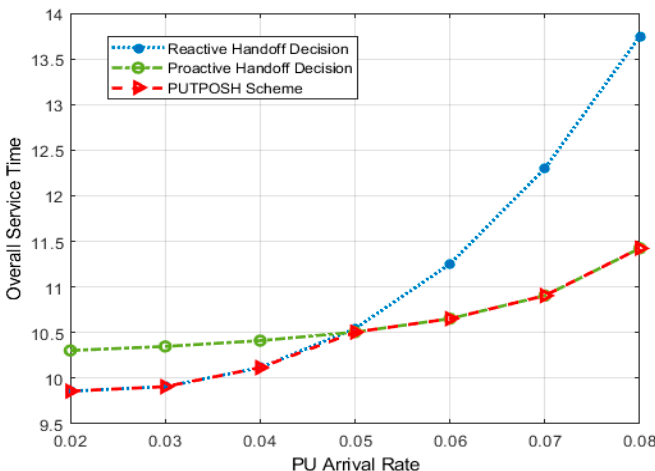
Figure 7. Comparison of primary user traffic pattern-based opportunistic spectrum handoff (PUTPOSH) with reactive and proactive handoffs w.r.t. the overall service time.